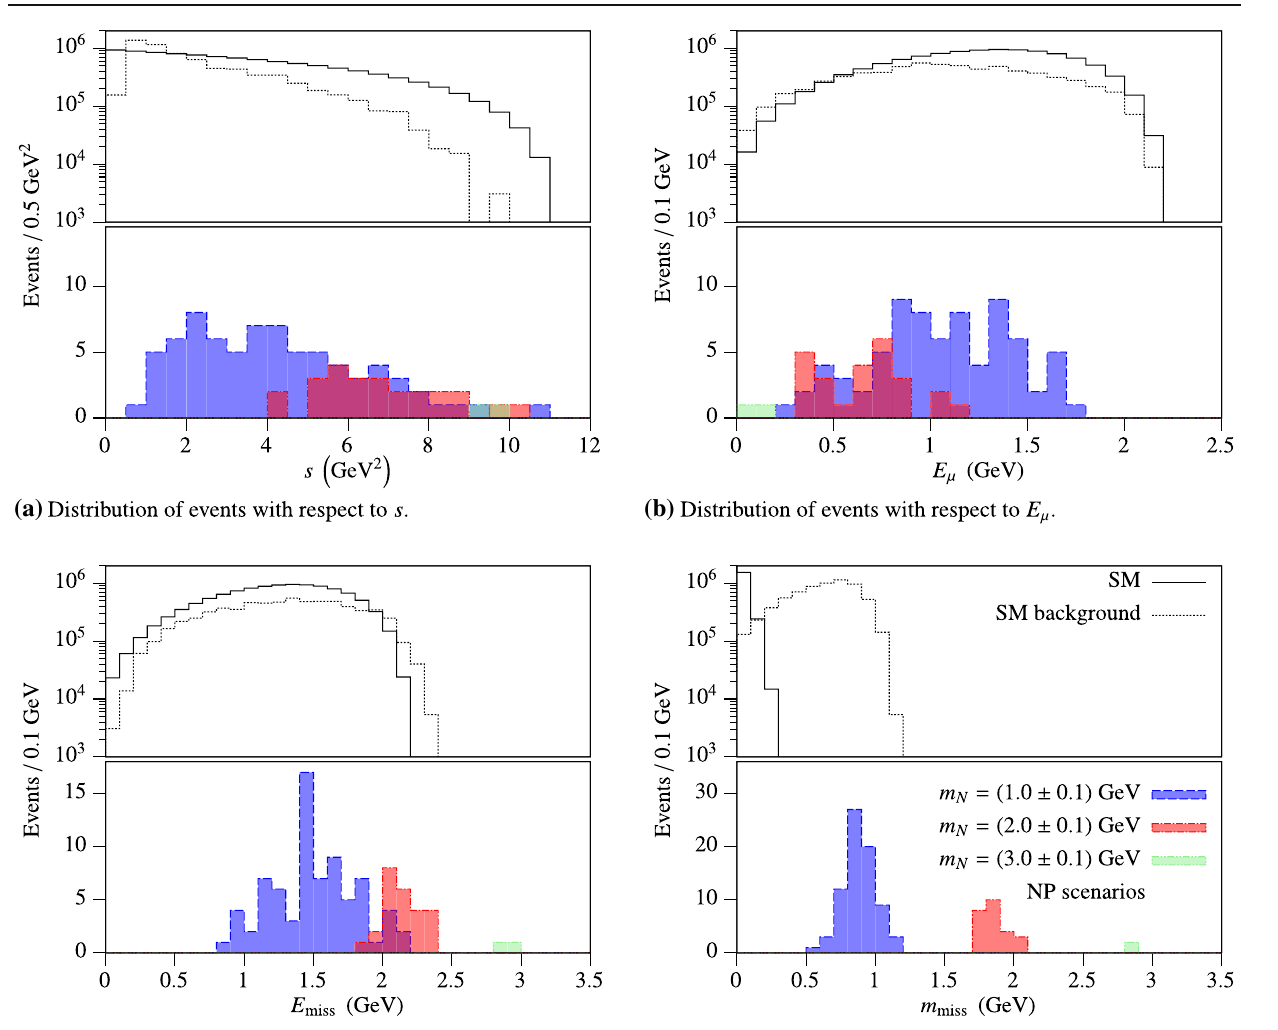
Fig. 2 Distribution of events corresponding to SM process B → D μν μ , SM background process B → D μν μ π soft /γ soft , and the new physics (NP) decays B → D μ N for m N = ( 1 . 0 , 2 . 0 , 3 . 0 ) ± 0 . 1 GeV, with respect to a few observables. Note that the number of events for